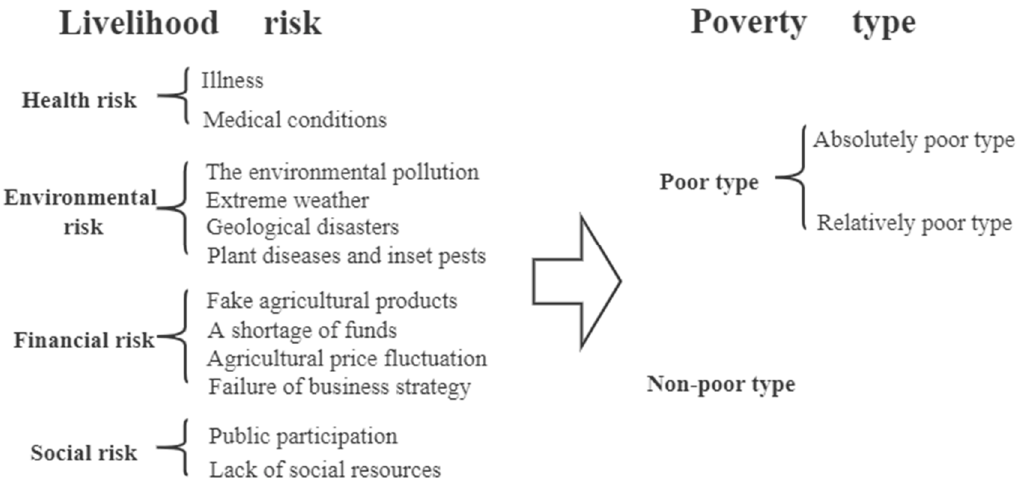
Figure 1. Livelihood risk and poverty type mechanism diagram.